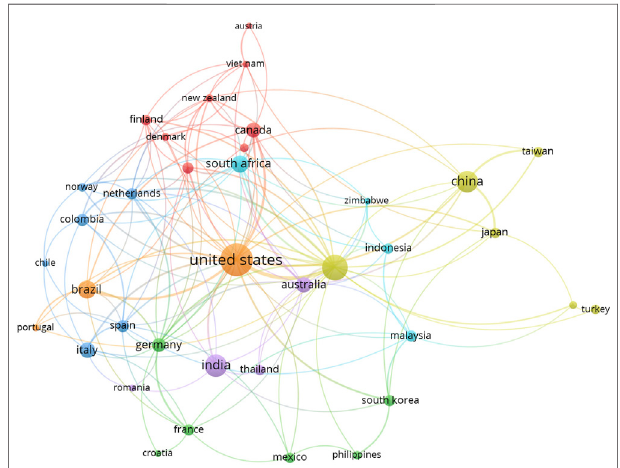
FIGURE 6 | Global cooperation network of countries in sustainable crafts. Source: Authors ’